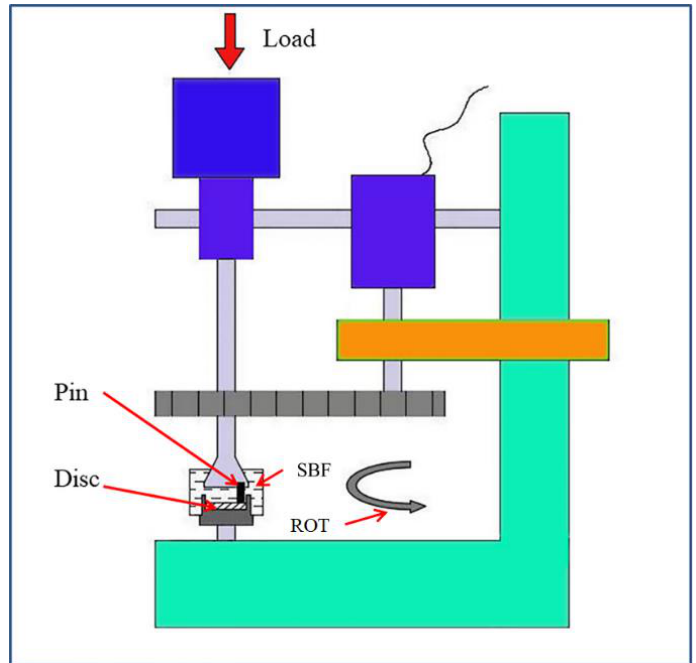
Figure 1. Schematic diagram of pin-on-disc testing machine.